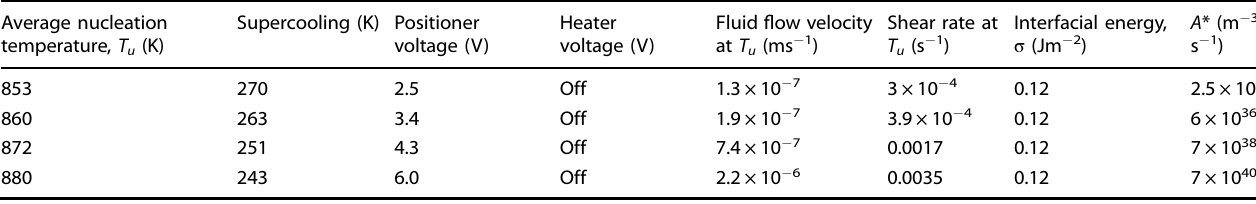
Table 1. Experimental data for Vit106 (Zr 57 Cu 15.4 Ni 12.6 Al 10 Nb 5 ). Average nucleation temperature, T u (K)